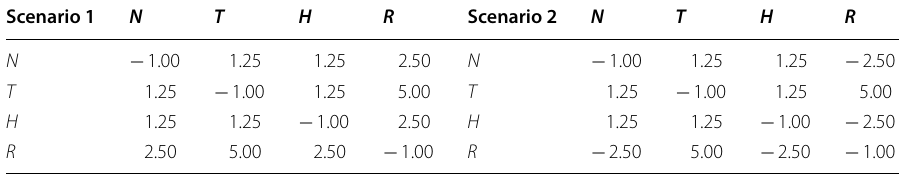
To assume the elasticity of substitution, we consulted Wissema and Dellink (2007) and Benavente (2016) N , T , H , and R indicate nuclear, thermal, hydro, and renewable power generation, respectively